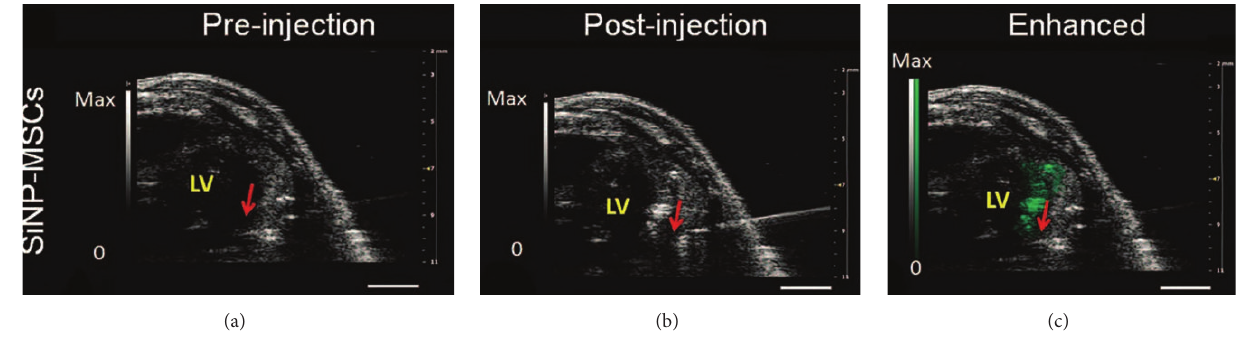
Figure 7: Ultrasound imaging of SCT. Silicon nanoparticles (SiNP) enhance the ultrasound signal of MSCs after cardiac implantation. Ultrasound resolves the needle catheter and the tissue. As shown in (c), the contrast signal due to the backscatter of SiNP highlights the implanted cells. Green signal indicates presence of stem cells. Red arrow highlights the bevel of the needle. Reproduced courtesy of the American Association for the Advancement of Science